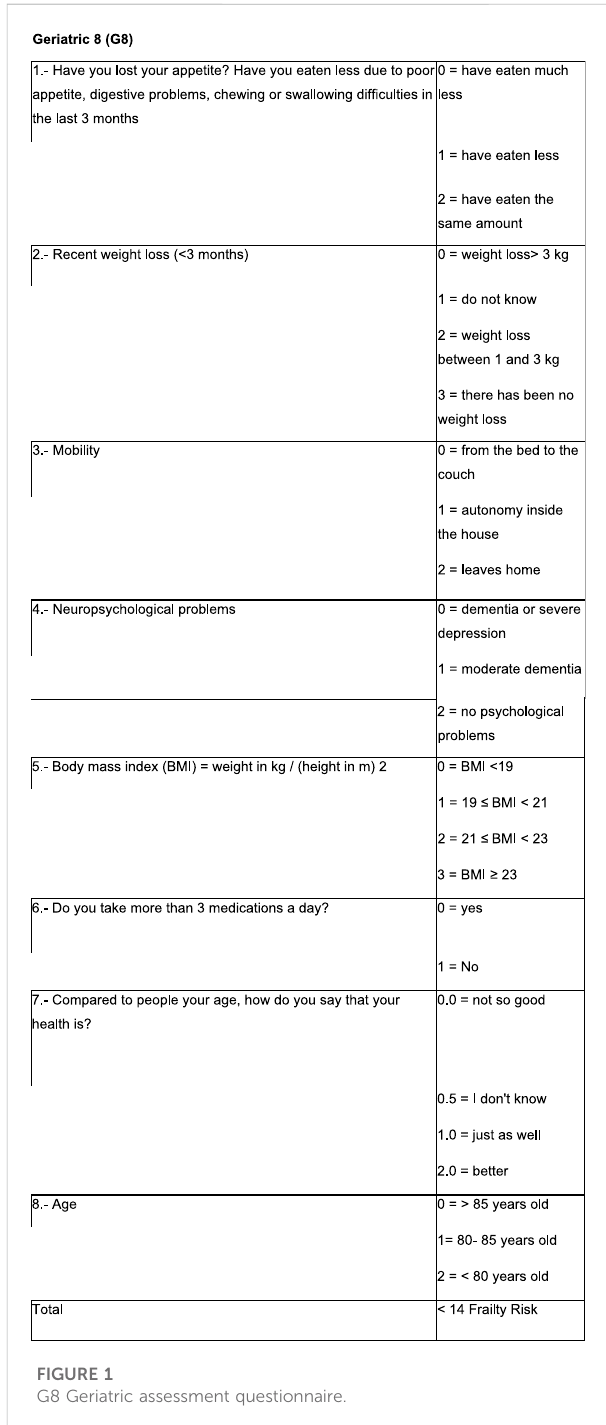
FIGURE 1 G8 Geriatric assessment